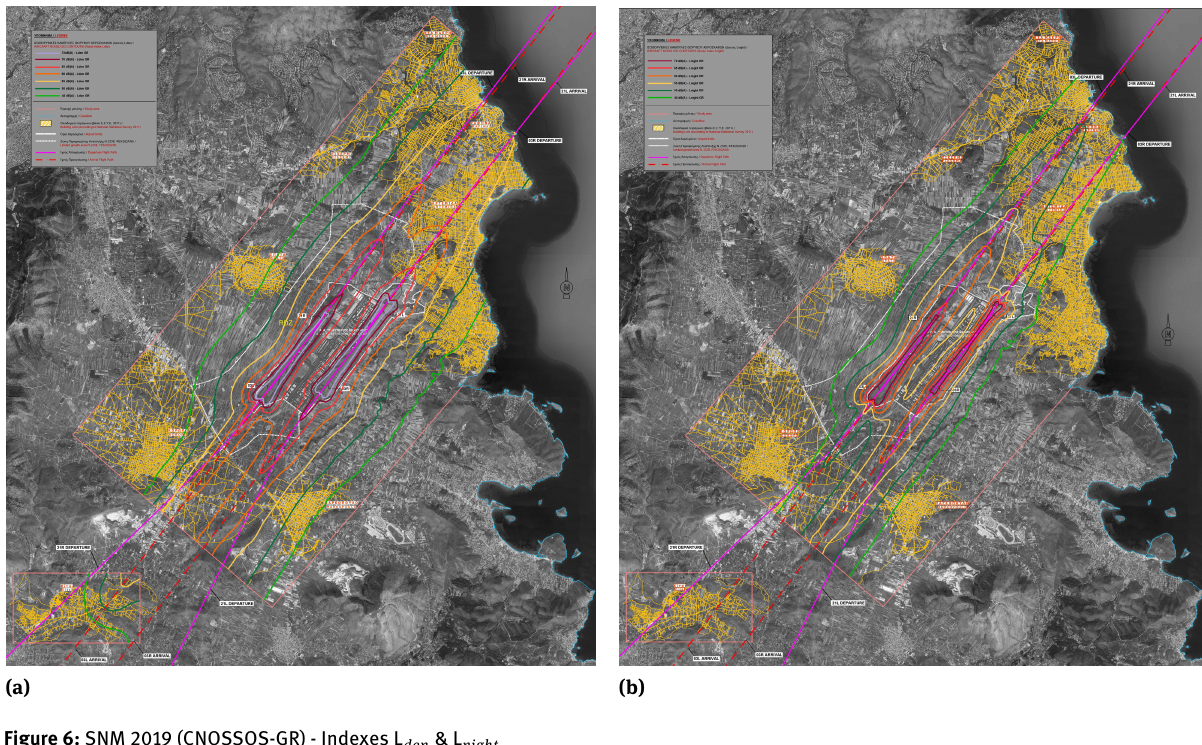
Figure 6: SNM 2019 (CNOSSOS-GR) - Indexes L den & L night